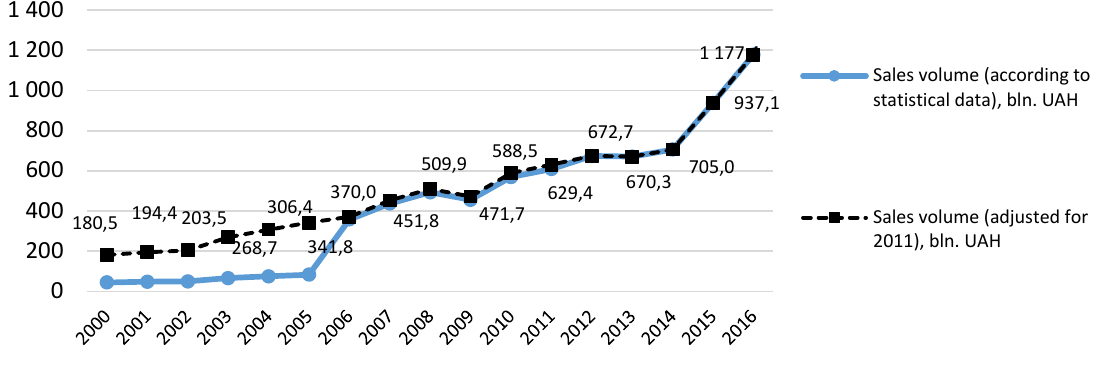
Figure 2. The sales volume of small business of Ukraine in 2000–2016 taking into account the changes in legislation in 2008 and in